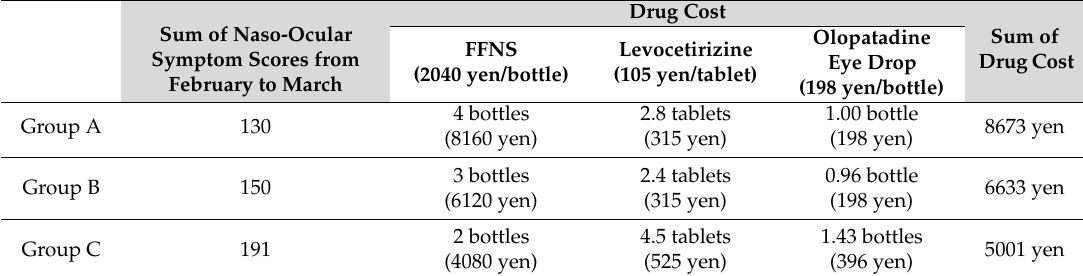
Table 2. Sum of the total naso-ocular symptom score and the drug cost over the study period for each treatment group.